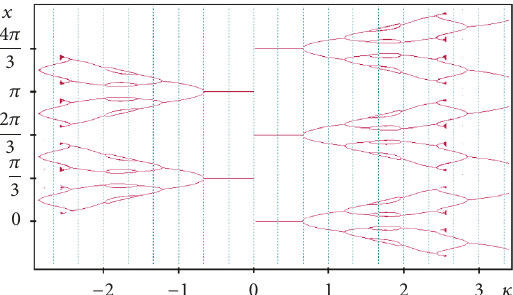
Figure 5: The figure shows a bifurcation diagram for the iterative map 𝑥 𝑛+1 = 𝑥 𝑛 − 𝜅 exp (− sin 2 (3𝑥 𝑛 )) sin (3𝑥 𝑛 ) ; an alternating sequence of tree-like graphs goes upwards and downwards. Stable fixed points bifurcate in different 𝑛 -cycles for |𝜅| > 2/3 . Stable fixed points bifurcate in a 2-cycle for 𝜅 = 2/3 ; then a cascade of bifurcations appears, leading to chaos, at least in some small regions. The 2-cycle may model a dilemma, since agent’s opinion jumps from one posture to another. Other 𝑛 -cycles may model other doubt processes in